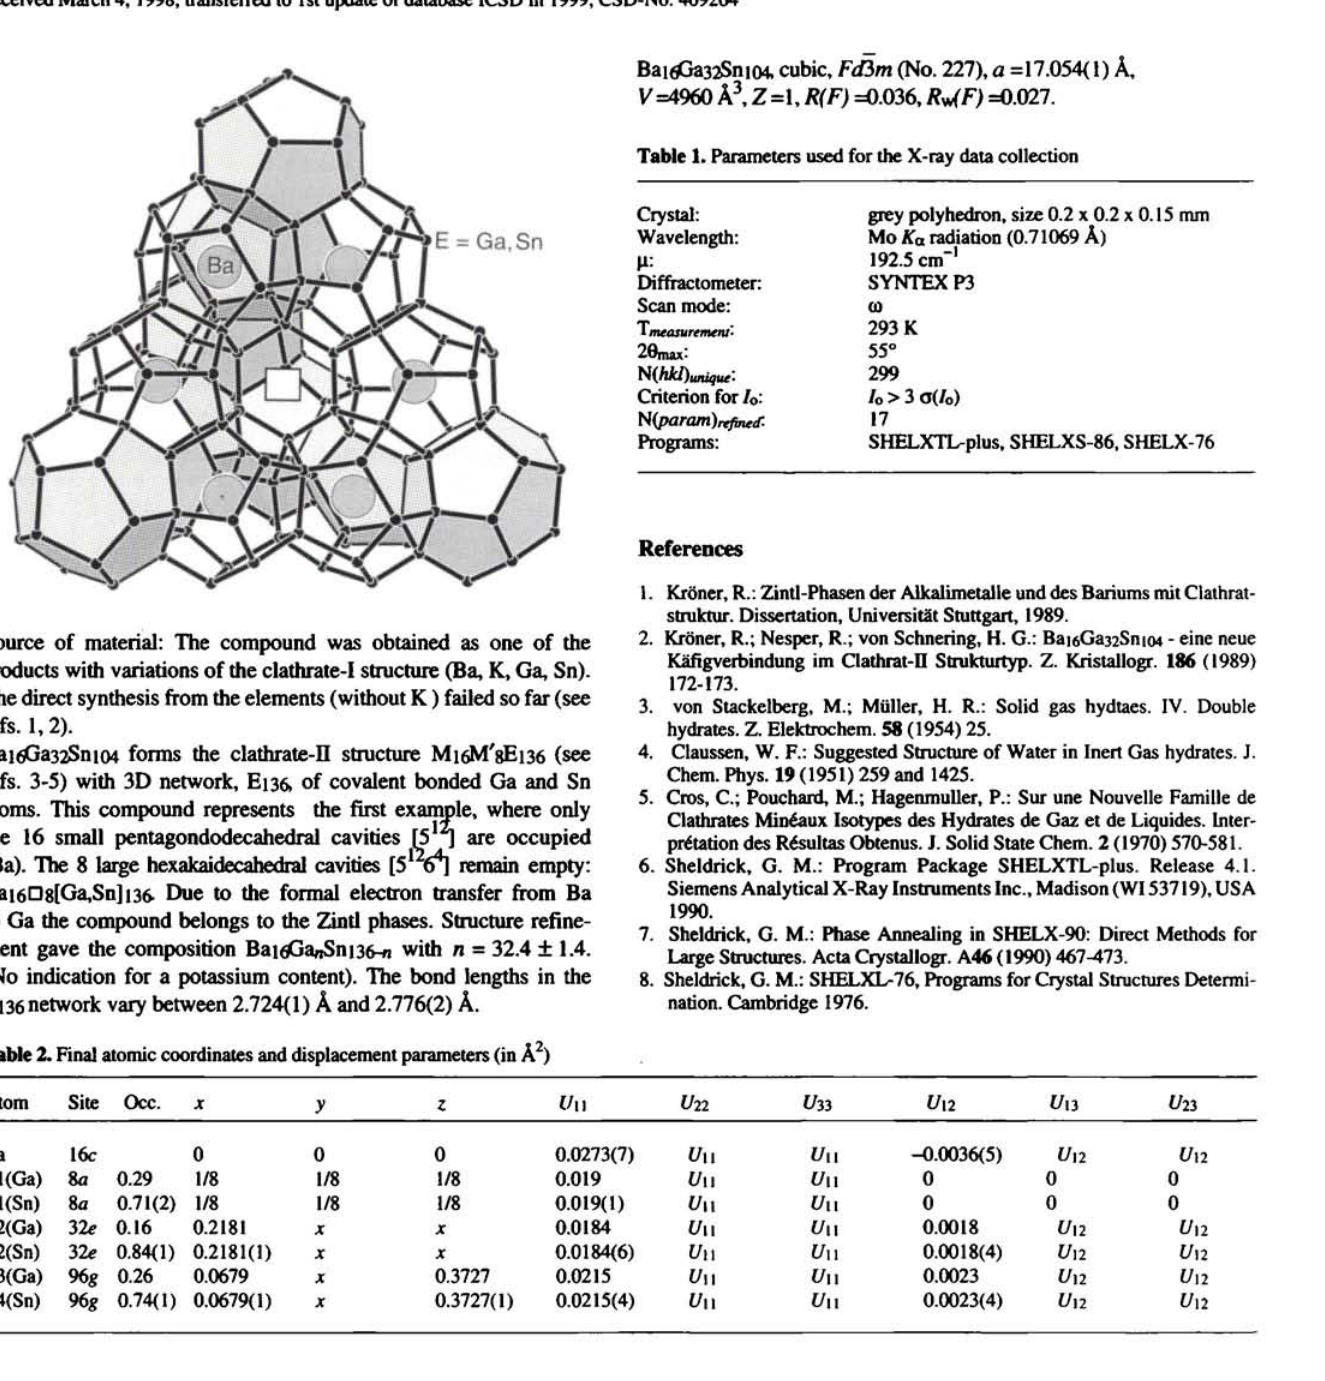
Table 1. Parameters used for the X-ray data collection Crystal: